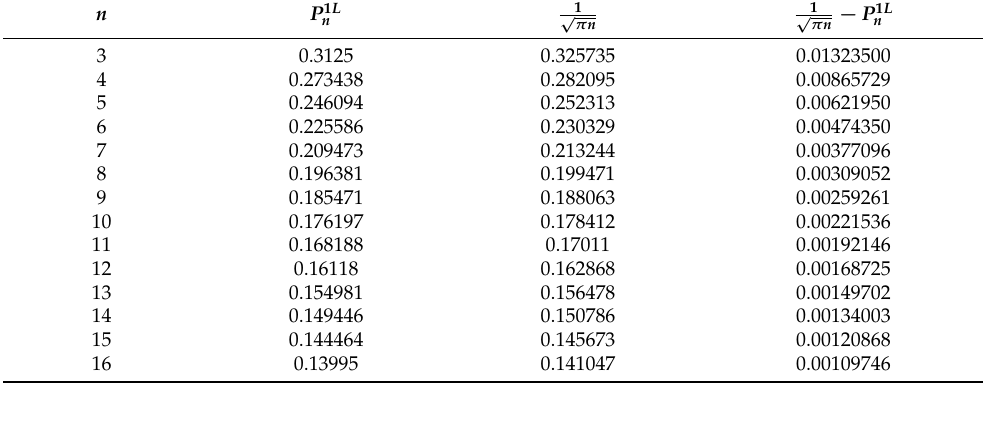
is greater than the exact P 1 4